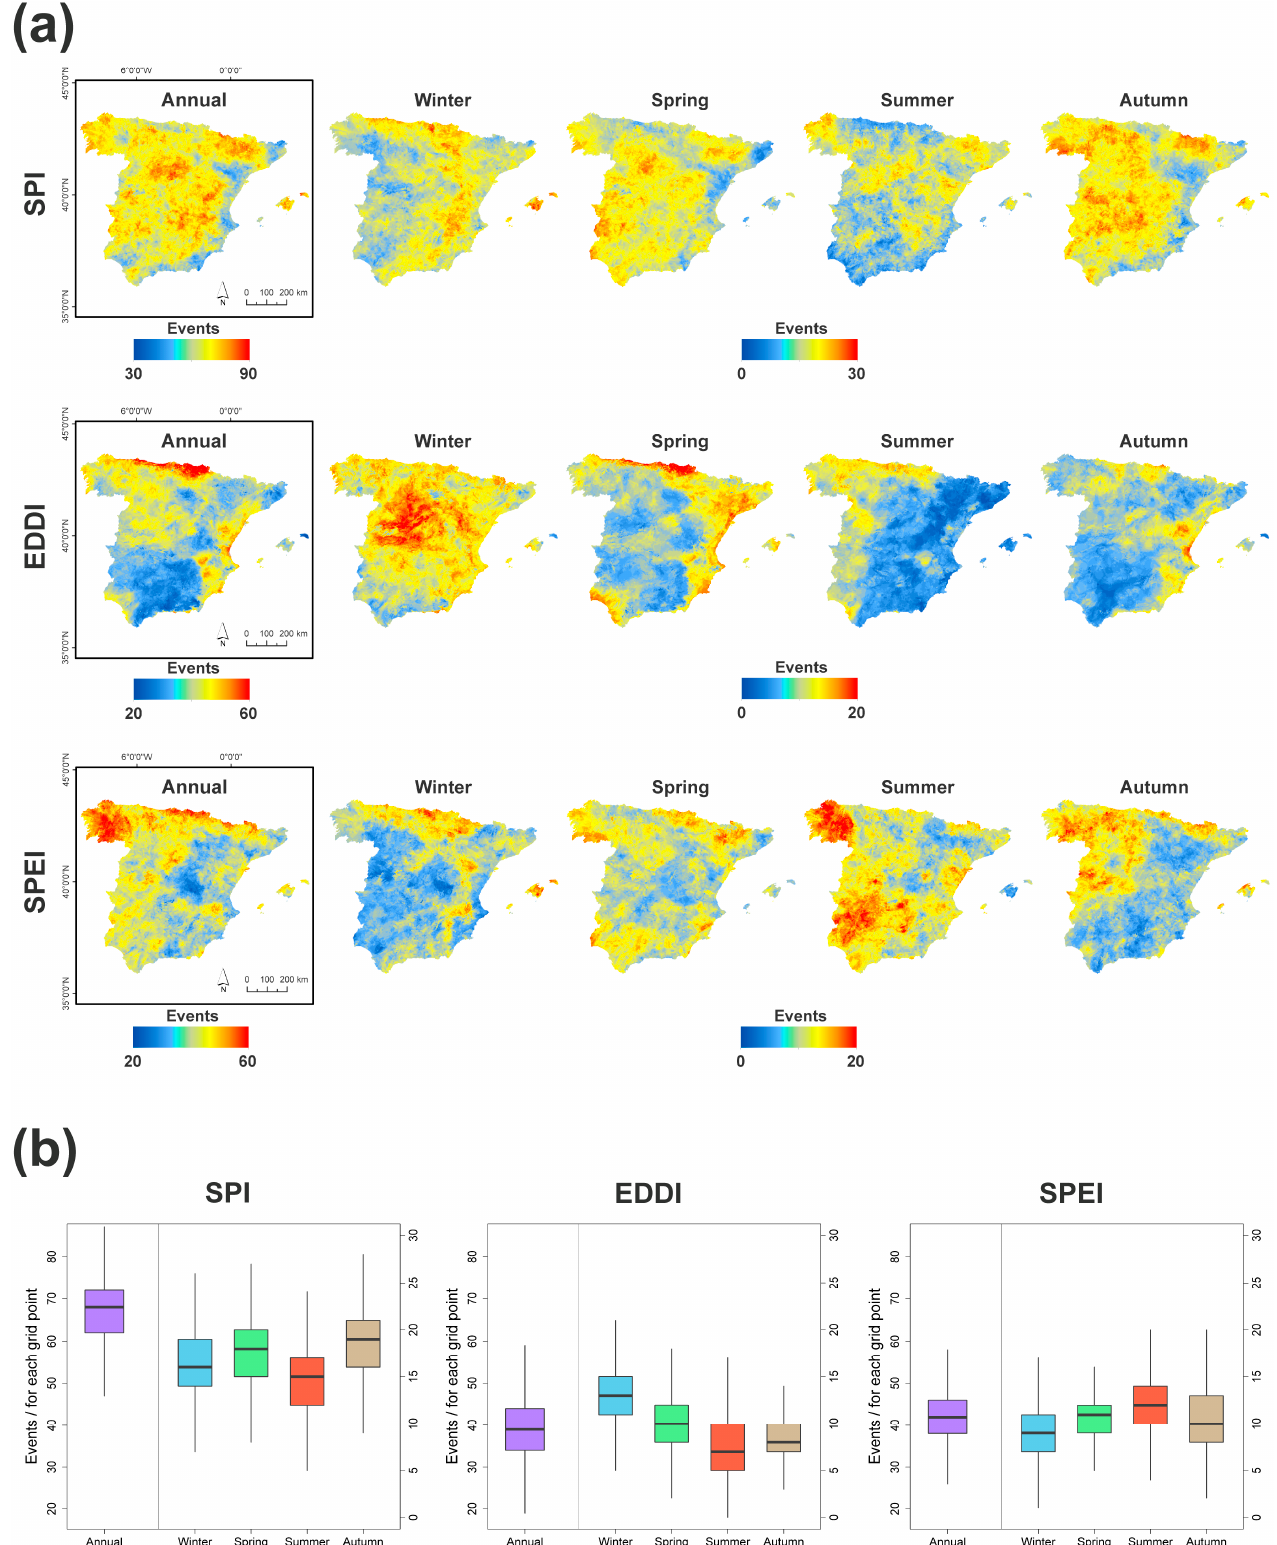
Figure 3. Annual and seasonal ( a ) spatial distribution for the frequency of flash droughts (events/for each grid point) identified by the SPI, EDDI, and SPEI over the period 1961–2018, ( b ) box plots summarizing the annual and seasonal frequencies obtained with the different indices. In the box plot, the left axis represents the annual data and the right axis represents the seasonal